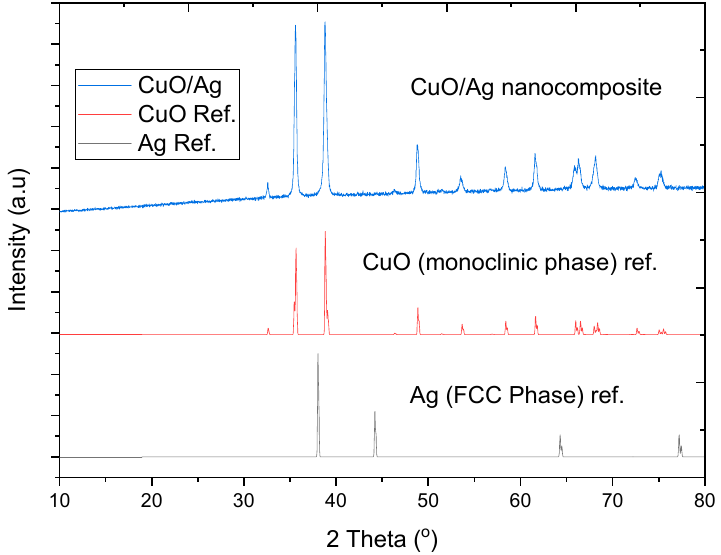
Figure 2. X-ray diffraction (XRD) spectrum of CuO/Ag correlated with the reference data of CuO monoclinic phase, adapted from Ref. [20] and the face-centered cubic (FCC) phase of Ag, adapted from reference [23].